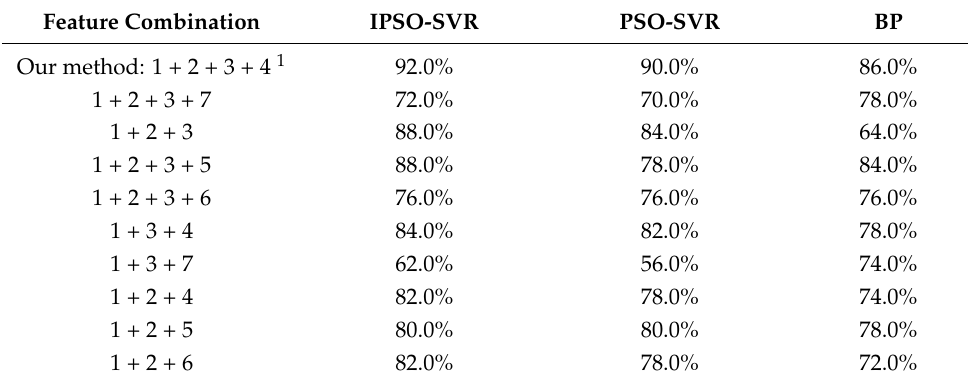
Table 14. The accuracies of IPSO-SVR, PSO-SVR, and BP neural network. Feature